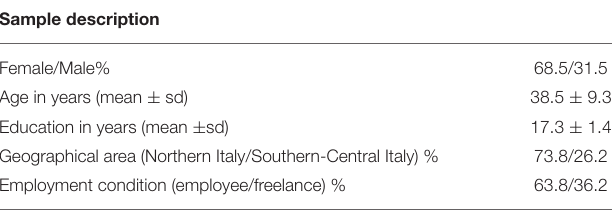
TABLE 1 | Descriptive characteristics of the sample.